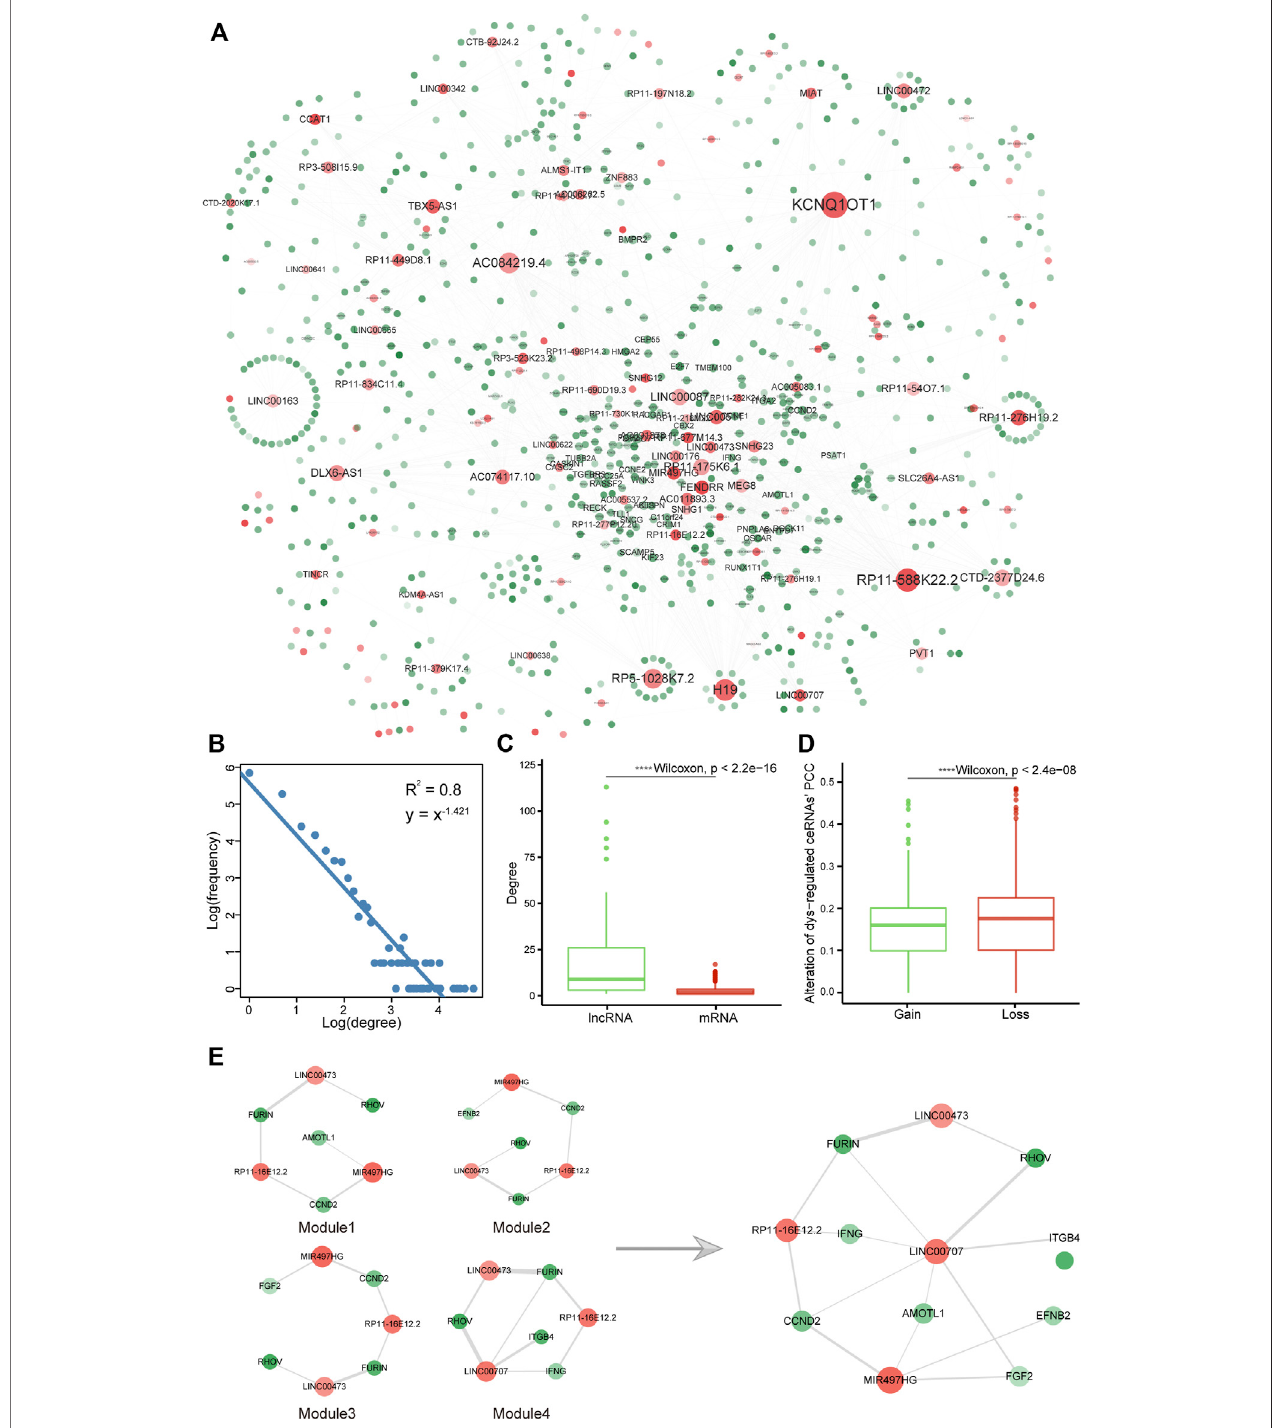
FIGURE 3 | Construction of a CIN-related dysregulated ceRNA network. (A) CIN-related dysregulated double-weighted ceRNA network, in which mRNAs and lncRNAswerecoloredgreenandred,respectively.Nodedegreewasindicatedbythenodesize,andnodeweightandedgeweightwereindicatedbynodetransparency and edgewidth,respectively. (B) Degreedistributionofthenetwork.Boxplots of (C) mRNAandlncRNAdegreeand (D) alterationofceRNAdysregulationextent inCIN- High compared with CIN-Low samples. (E) Subnetwork CRDC connected by dense modules after screening and integration.